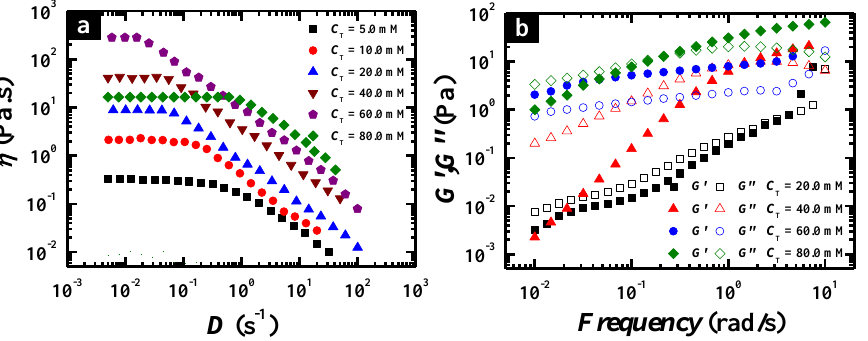
Figure 10. Rheological properties of C 12 C 3 C 12 (SO 3 ) 2 /CTAB mixtures at X g = 0.70. ( a ) Steady shear viscosity, ( b ) elastic modulus G ′ and viscous modulus G ″ as functions of angular frequency ω .